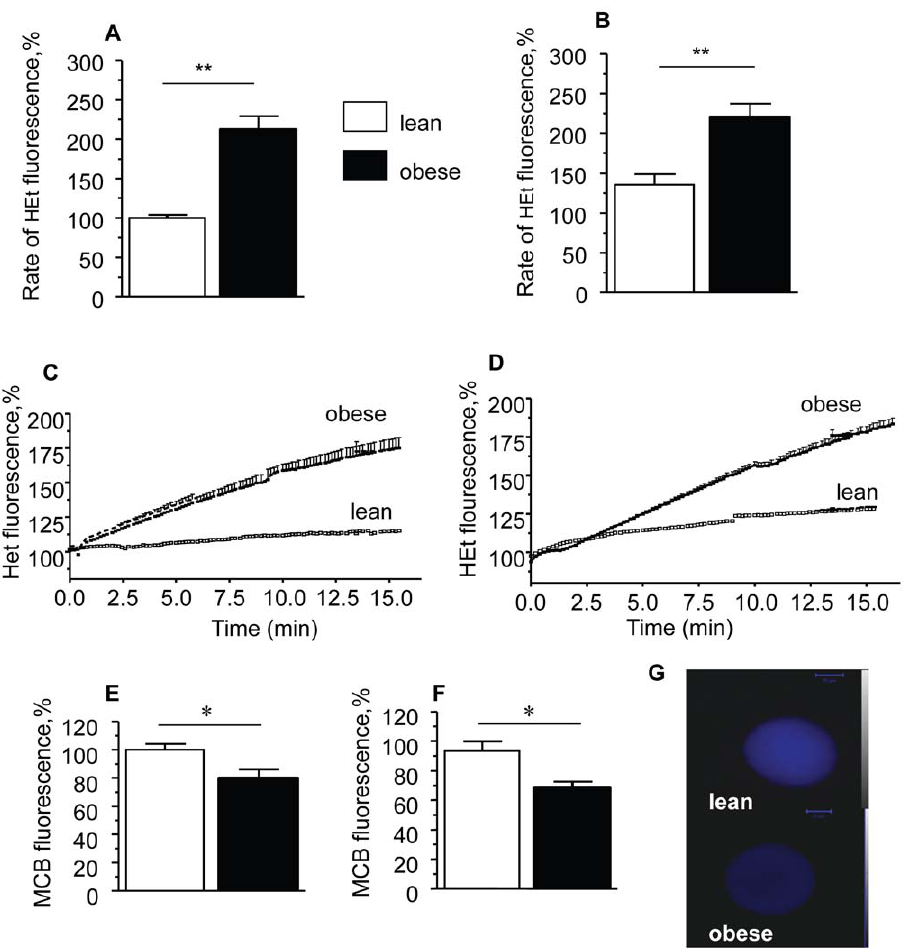
Figure 3. Maternal diet induced obesity increases rates of ROS generation and depletes glutathione in oocytes and zygotes. Cytosolic ROS production in oocytes and zygotes was measured by rate of oxidation of HEt. The traces represent changes of HEt fluorescence in oocytes (A) and zygotes (B) from lean (n=15 cells/group) and obese (n=15 cells/group) mice as a function of time. These data are summarised in histograms (C, D), in which the mean rates of ROS production are shown as the mean rate of HEt fluorescence change per minute. Results are expressed as percentage changes from HEt fluorescence in lean oocytes. Intracellular glutathione staining with MCB in oocytes (E) and zygotes (F) recovered from lean and obese female mice. Relative intensity of MCB fluorescence is expressed as a percentage of the signal from oocytes of lean mice. (G) Representative confocal images of GSH staining in oocytes. * p , 0.05, ** p , 0.01. Data are mean 6 SEM.